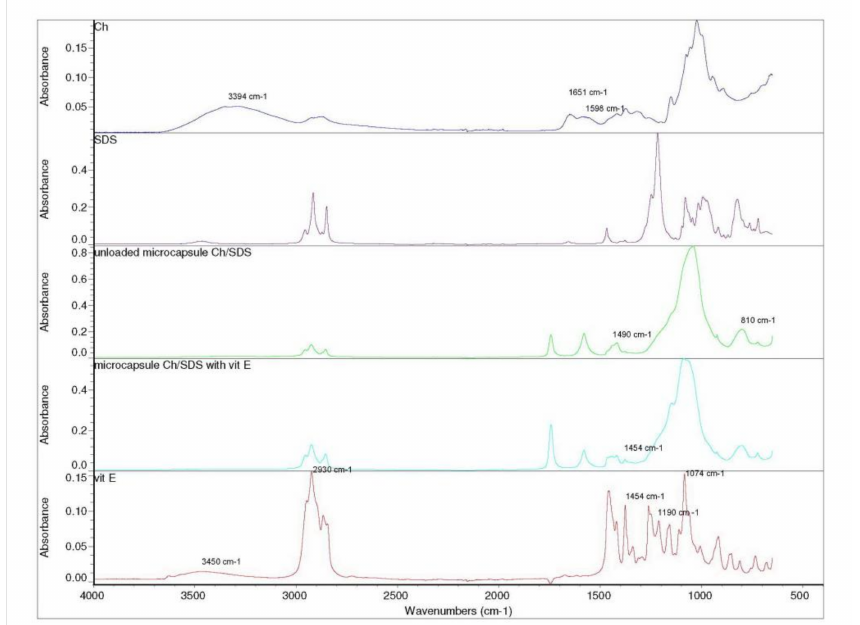
Figure 5. FTIR spectra of chitosan, SDS, vitamin E, unloaded Ch/SDS microcapsules, and Ch/SDS microcapsules loaded with vitamin